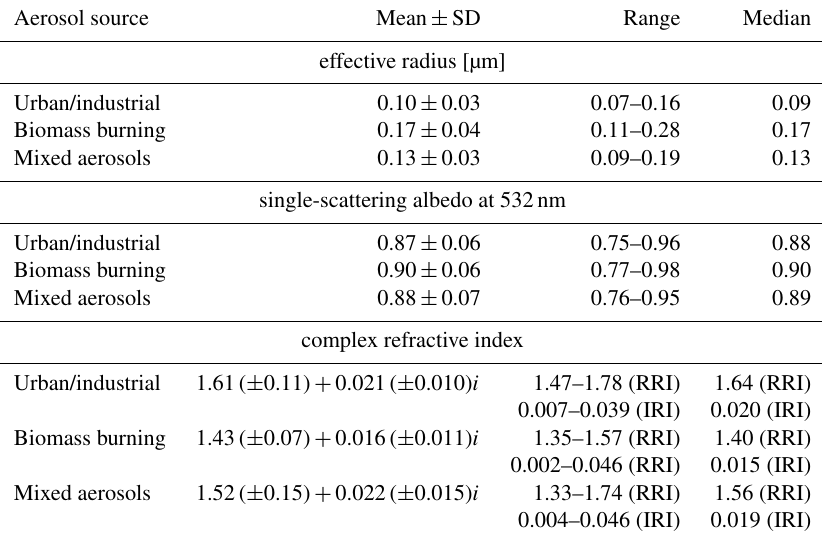
Table 3. Mean value ± standard deviation of effective radius and single-scattering albedo for the examined aerosol types, as well as range and median. RRI: real refractive index; IRI: imaginary refractive index.